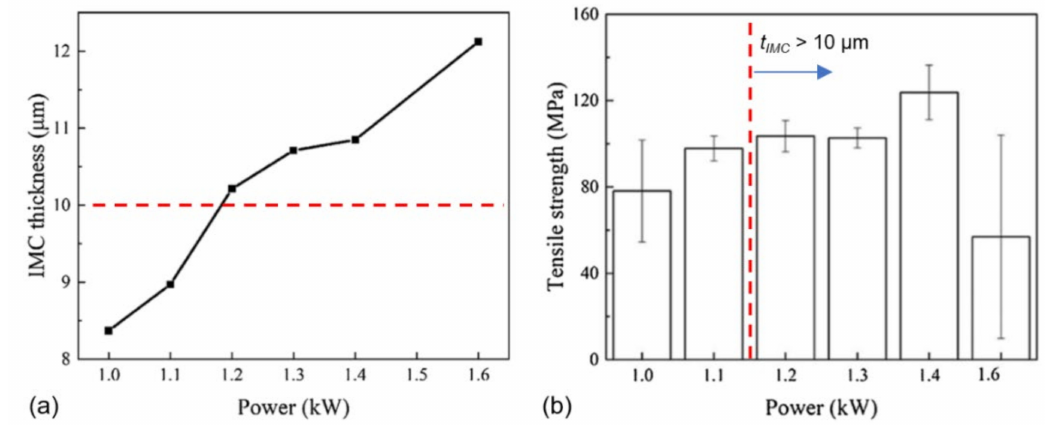
Figure 14. ( a ) Effect of laser power on IMC layer thickness and ( b ) effect of laser power on mechanical properties. From